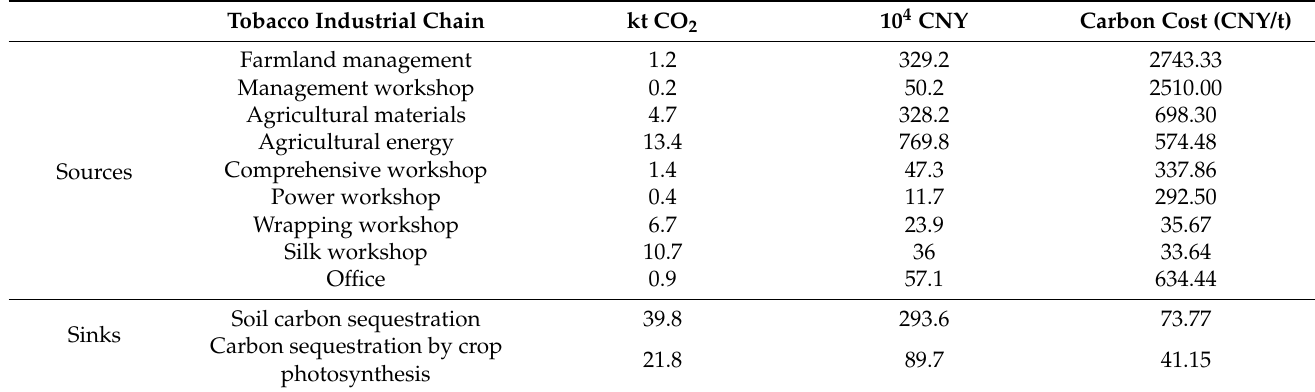
Table 4. Accounting for the tobacco industrial chain with an input of 30% clean energy.